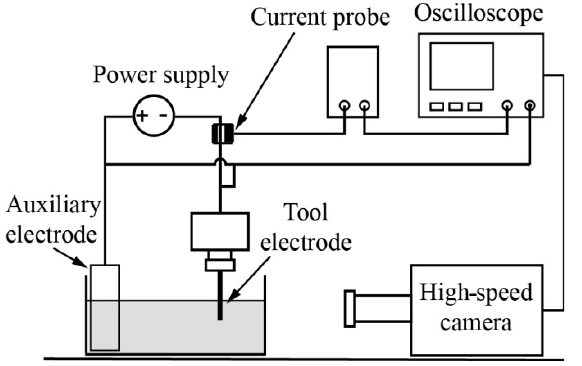
Figure 1. Experimental setup for capturing the discharge phenomenon and the gas film formation. Table 1. Experimental parameters of electrochemical discharge high − speed imaging.